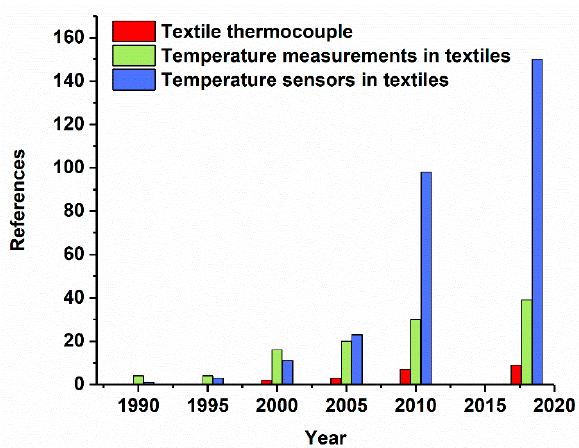
Figure 3. Number of concepts for the integration of temperature measurement systems and thermocouples into textiles published until 2019. The SciFinder database was used for the literature search with the key words textile thermocouples, temperature measurements in textiles, and temperature sensors in